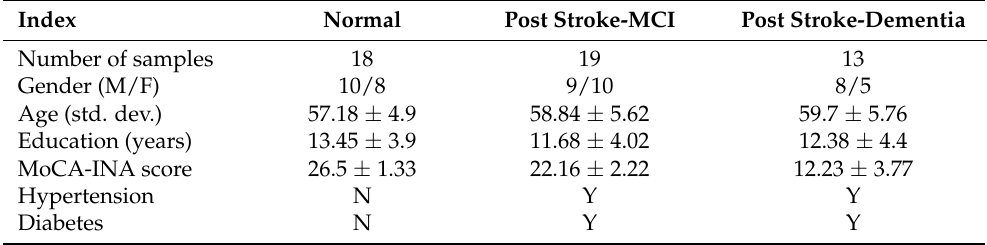
Table 1. Clinical data of research subjects.